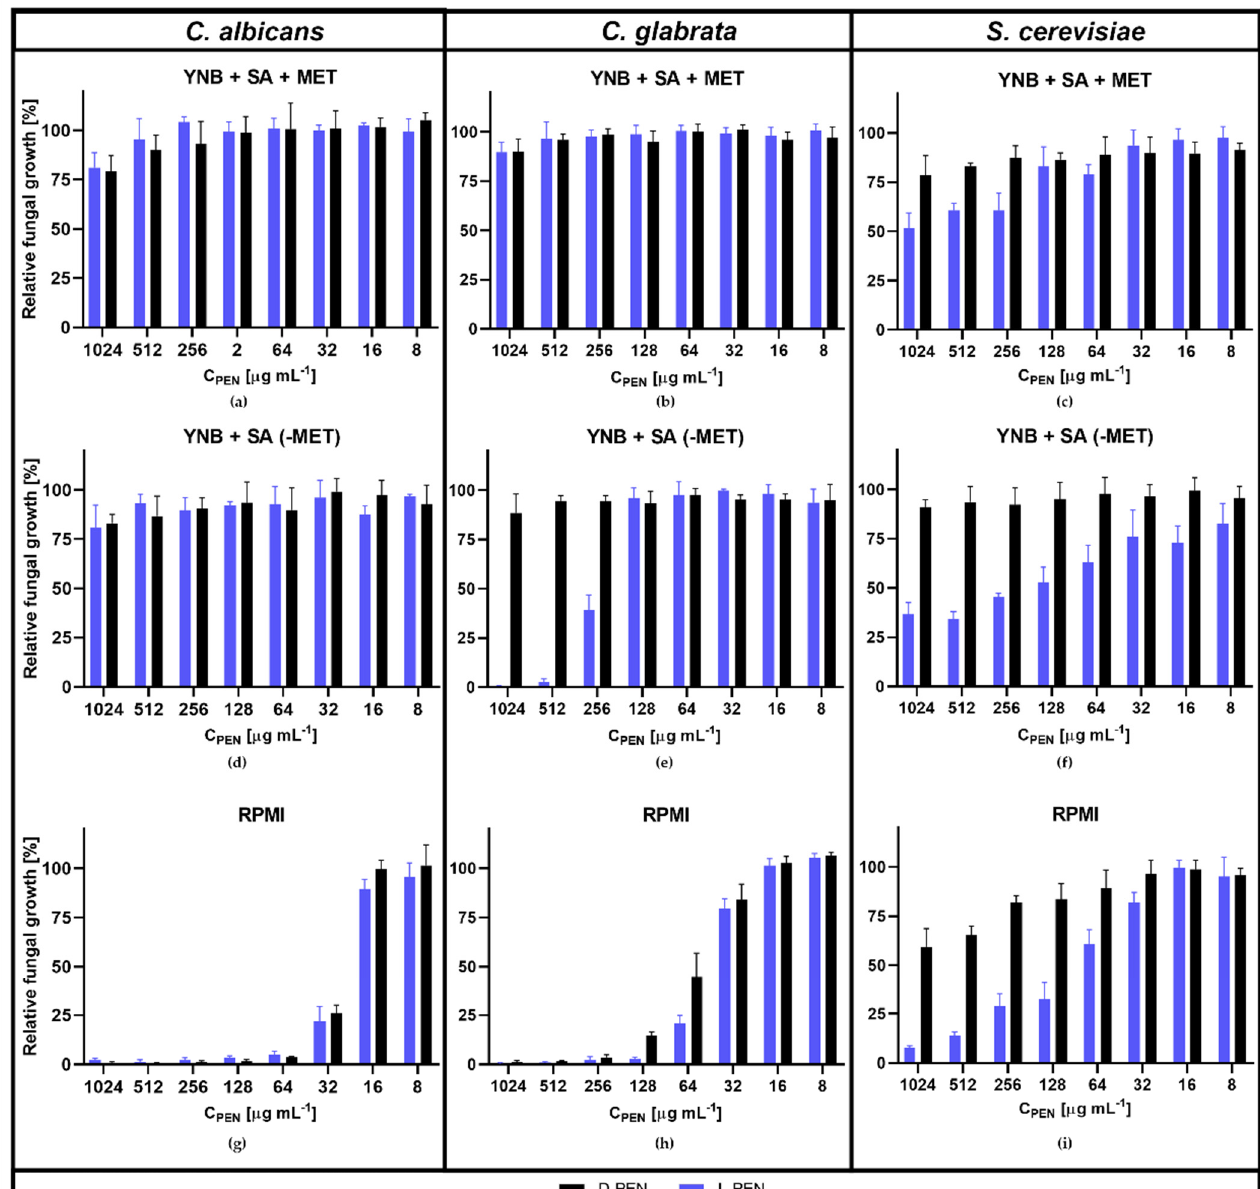
Figure 8. Inhibition of C. albicans, C. glabrata , and S. cerevisiae growth by L-Pen and D-Pen in YNB + SA ± 10 mM L-Met medium ( a – f ), and in RPMI medium ( g – i ). The error bars represent the standard deviation (SD).